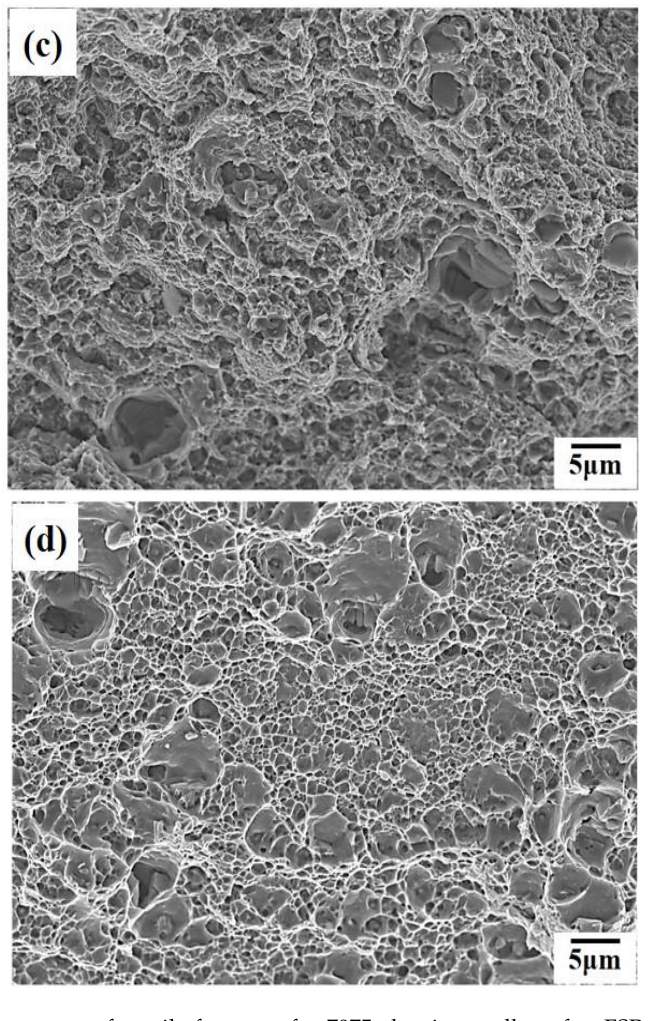
Figure 5. Microstructures of tensile fractures for 7075 aluminum alloy after FSP and various heat treatments: ( a ) BM-O specimen, ( b ) BM-W specimen, ( c ) 440-NA specimen, ( d ) 440-W specimen.